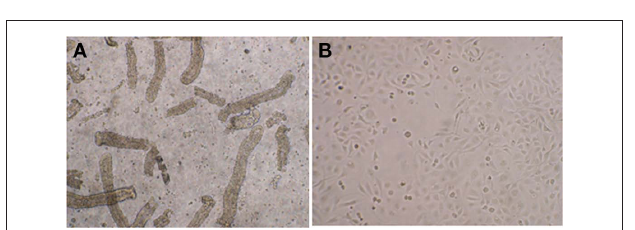
FigUrE 2 | Establishment of primary bovine rectal epithelial (PBrE) cells. (A) Crypt bodies released from biopsies of the terminal rectal mucosa after 2 h enzymatic digestion at 37 ° C. Incubation at 37 ° C in supplemented DMEM medium for 6 days gave rise to (B) a confluence monolayer of epithelial cells. Both representative images taken by inverted microscopy (original magnification, ×